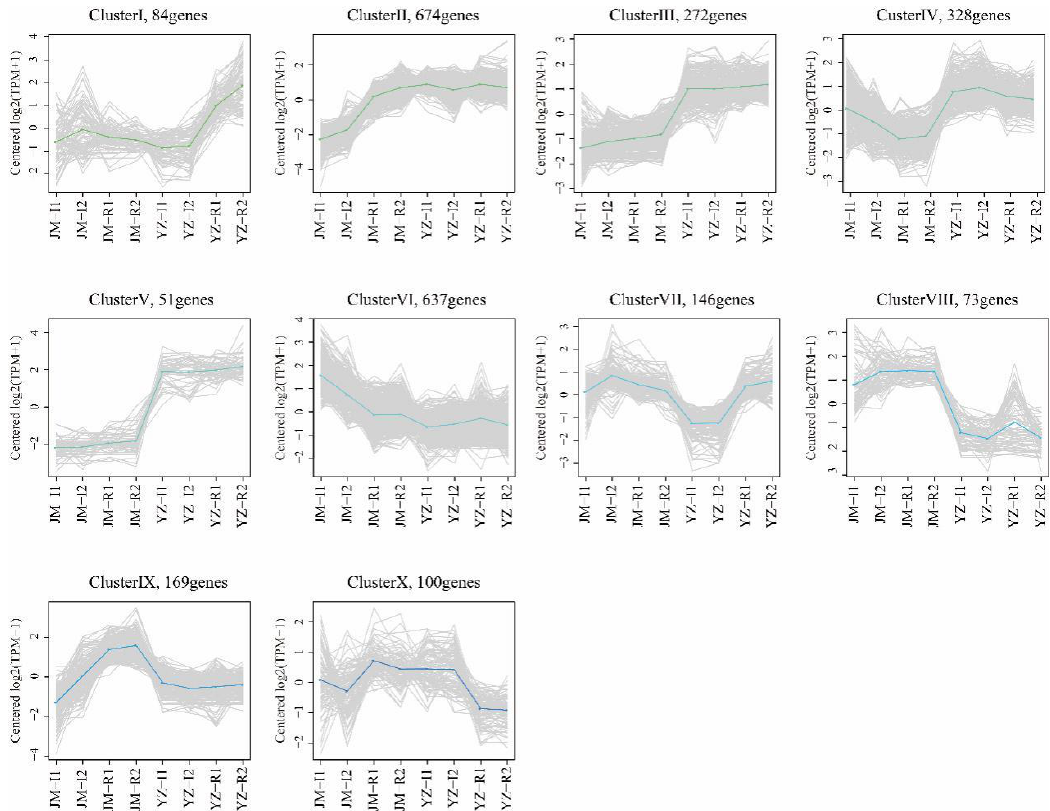
Figure 4. Comparison of KEGG enrichment analysis of the DEGs in drought-tolerant and drought-sensitive genotypes. ( A ): drought-tolerant genotype Jimai No. 47; ( B ) drought-sensitive genotype Yanzhan No. 4110.